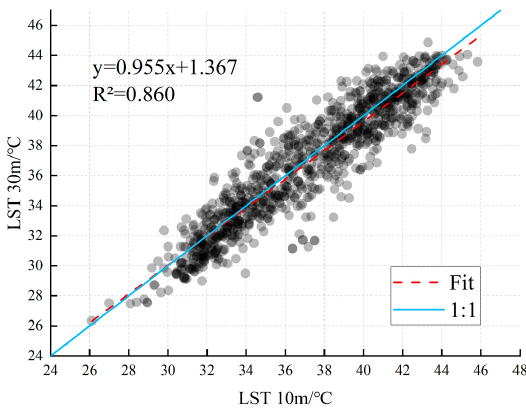
Figure 4. Accuracy verification results of downscaling LST (10 m) and L8 LST (30 m).